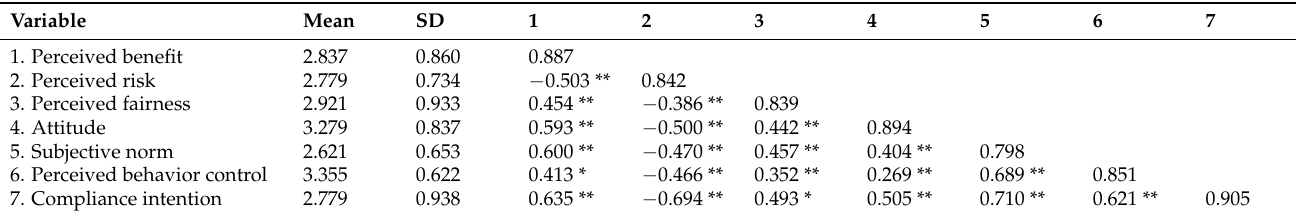
Table 2. Descriptive statistics and Pearson’s correlations among